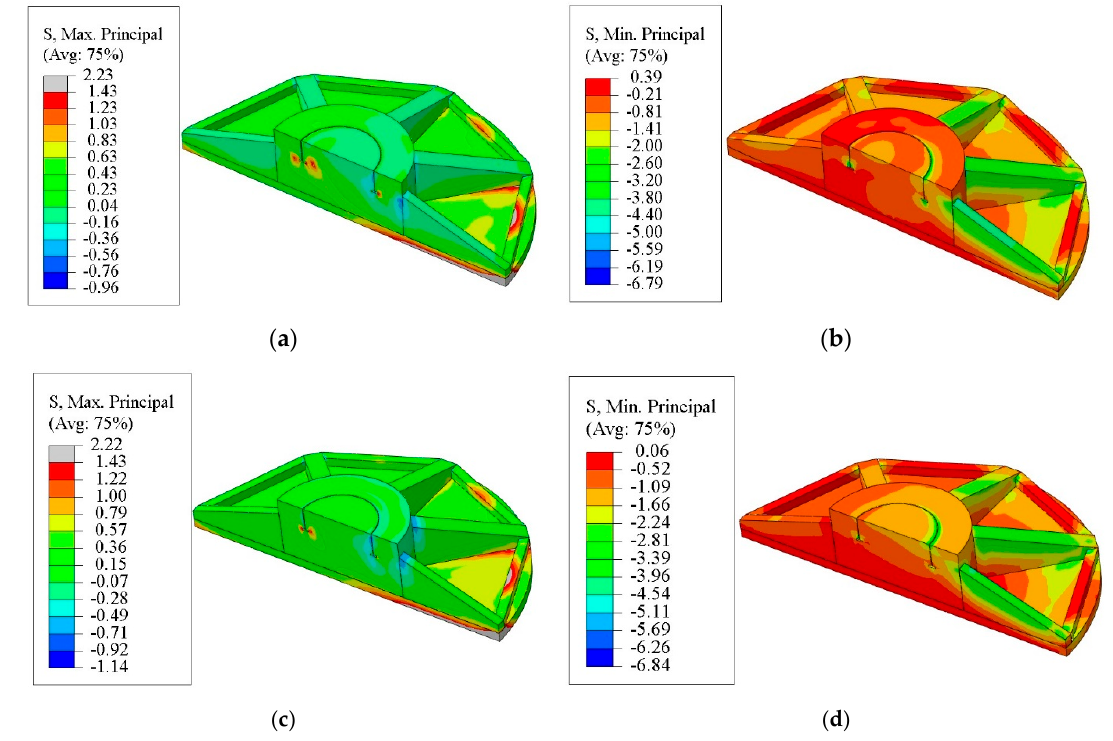
Figure 13. Maximum and minimum principal stress of the foundation concrete before and after strengthening under the peak value of fatigue loading (MPa). ( a ) Maximum principal stress before strengthening; ( b ) Minimum principal stress before strengthening; ( c ) Maximum principal stress after strengthening; ( d ) Minimum principal stress after strengthening.